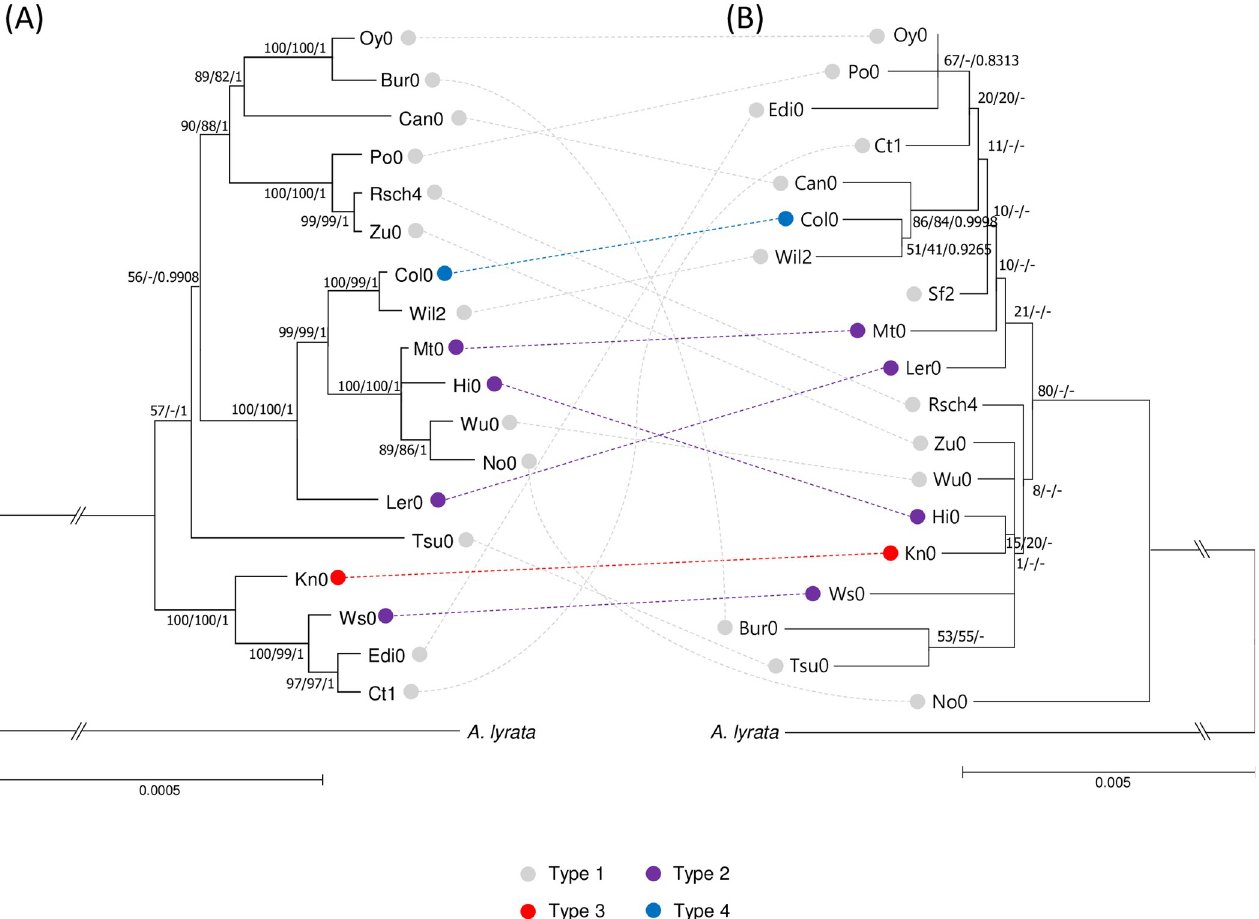
Fig 8. Phylogenetic relationship of GATA genes and chloroplast genomes of Arabidopsis ecotypes. (A) is a bootstrapped maximum-likelihood phylogenetic tree of 18 A . thaliana and A . lyrata chloroplast genomes. (B) presents a bootstrapped maximum-likelihood phylogenetic tree of concatenated common GATA genes across 19 A . thaliana ecotypes and A . lyrata . Numbers on branches in both phylogenetic trees indicate supporting values of maximum-likelihood, neighbor-joining, and Bayesian inference tree, respectively. The scale bars of both trees indicate estimated DNA substitutions per site. Gray, purple, blue, and red circles are corresponding to Types 1, 2, 3, and 4 mentioned in Fig 8 and Table 4, respectively. The dotted straight and curved lines connect the same ecotype in both trees.